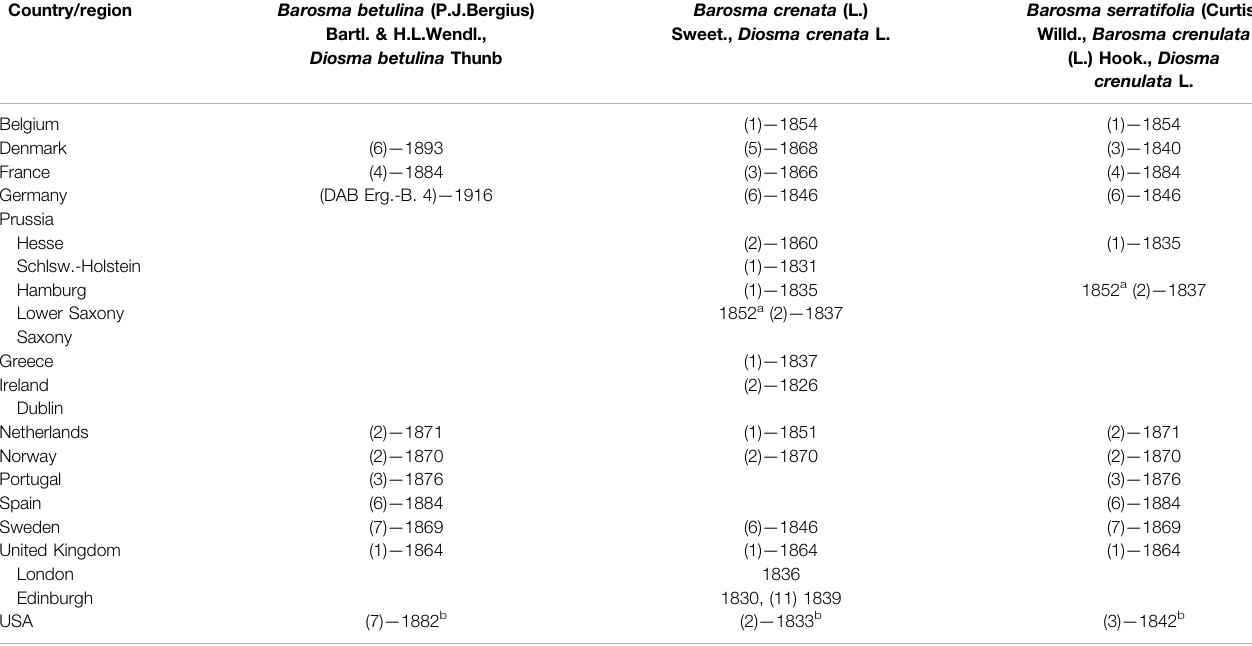
TABLE 2 | History of compendial representation of buchu , compiled from (Anonymous, 1826; Duncan, 1830; Pfaff, 1831; Wood and Bache, 1833; Anonymous, 1835; Anonymous, 1836; Anonymous, 1837; Royal College of Physicians of Edinburgh, 1839; Anonymous, 1842; Anonymous, 1846; Anonymous, 1860; Anonymous, 1916; Bruntz and Jaloux,